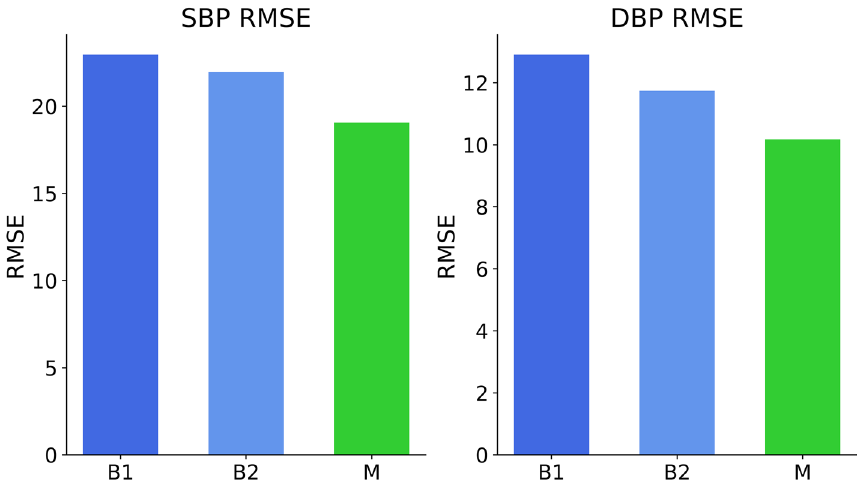
Figure 6. Base performances (B1-, B2-, M-RMSE) calculated for the systolic and diastolic MIMIC IV dataset. Systolic data variance is higher than diastolic. The M-RMSE shows a predictive benefit over the B1- and B2-RMSE for both systolic and diastolic values. The systolic RMSE values were B1 = 22.96, B2 = 21.97, M = 19.07. The diastolic RMSE values were B1 = 12.91, B2 = 11.74, M =